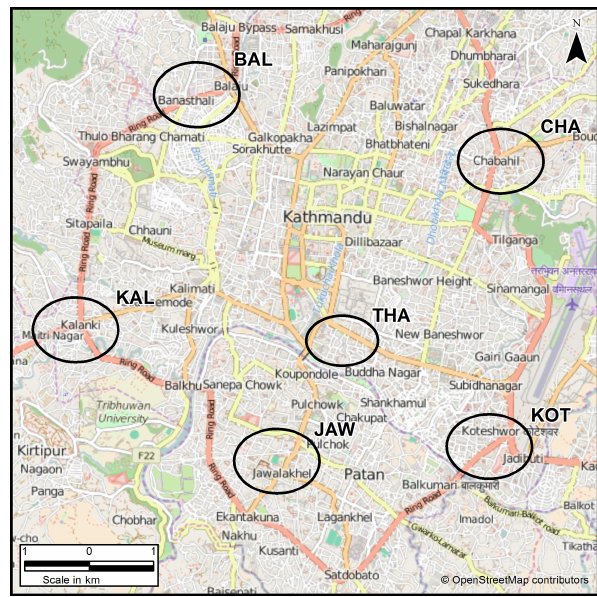
Figure 1. The six sampling sites used in this study. KAL: Kalanki, JAW: Jawalakhel, THA: Thapathali, KOT: Koteshwor, CHA: Chabahil, and BAL: